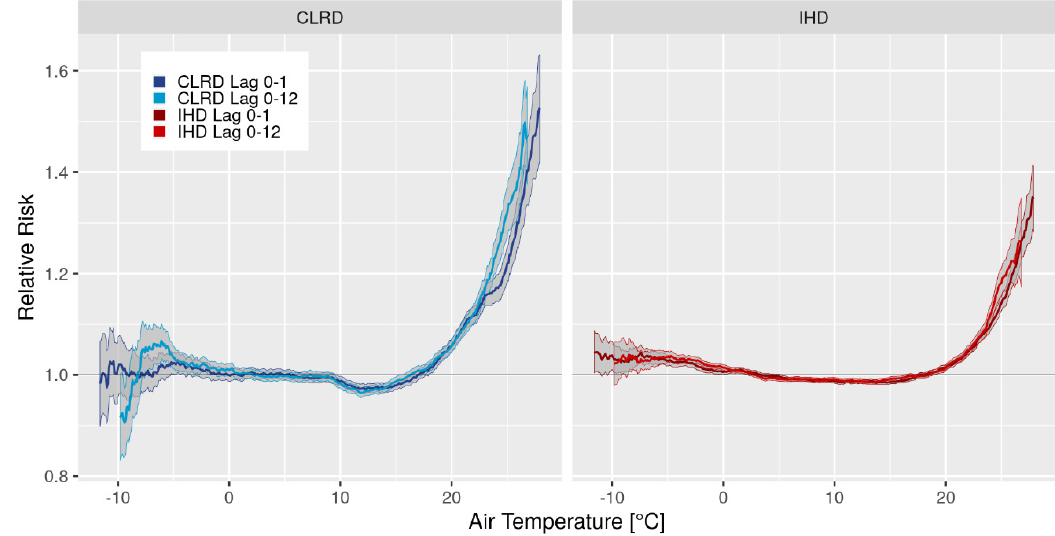
Figure 5. Relationship between Chronic lower respiratory diseases (CLRD) resp. ischemic heart diseases (IHD, red) mortality and air temperature, considering lag effects of the past 12 days (Lag 0-12 corresponds to the average temperature impact of 6 twin-days before days of mortality).